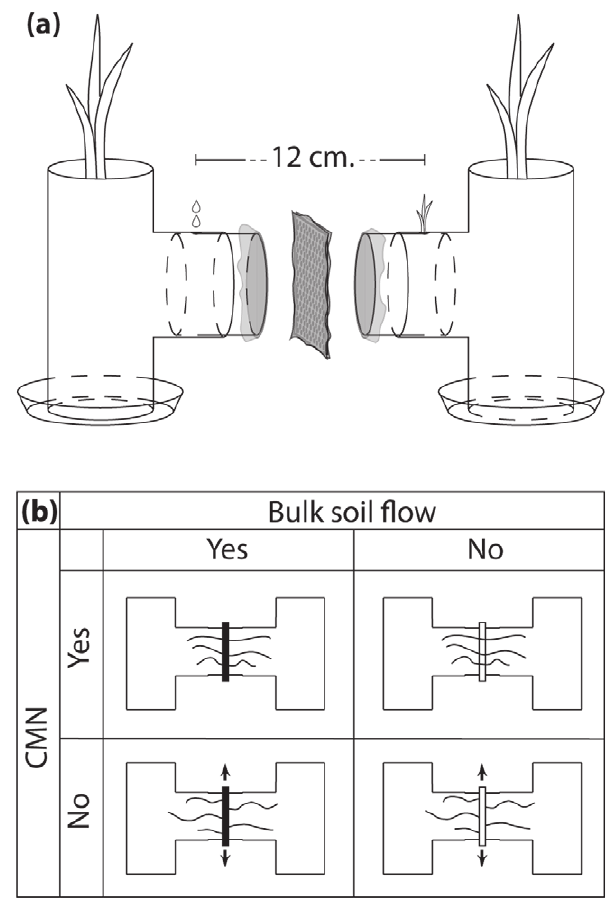
Figure 1. (a) Exploded view of H-pot construction, showing location of large nurse plants, small bioassay plant, the hole where imazamox was introduced to the soil (indicated by droplet symbols), and the four layers of mesh separating pot halves. (b) Experimental design, with solid steel plates indicating that soil was packed into the perforations in the steel plate, while open steel plates were left open creating an air gap. Arrows indicate that plates were moved daily.